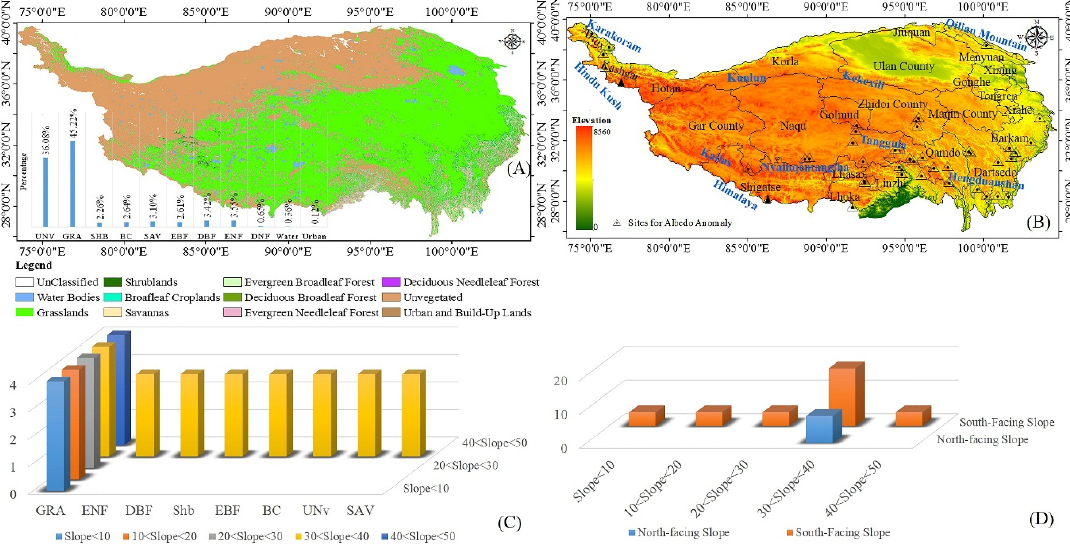
Figure 1. The land cover types ( A ) and the DEM ( B ) of the Tibetan Plateau (TP); The distributions of these three types of sites following the change of land cover change ( C ) and topographic slope and aspect ( D ). The subplot in Figure 1A shows the percentage of the area covered by different land cover types to the TP. The hollowed triangle symbols in Figure 1B show the distribution of selected sites. The filled triangle symbols in Figure 1B show the location of Mt. Qogir K2 (in the northwest) and Mt. Everest (in the south). The names of counties (black color) and mountainous area (blue color) are also listed in Fig1. B. GRA= grasslands; Shb=shrublands; BC= broadleaf croplands; SAV= savannas; EBF= evergreen broadleaf forests; DBF=deciduous broadleaf forests; ENF=evergreen needleleaf forests; and UNV=unvegetated.